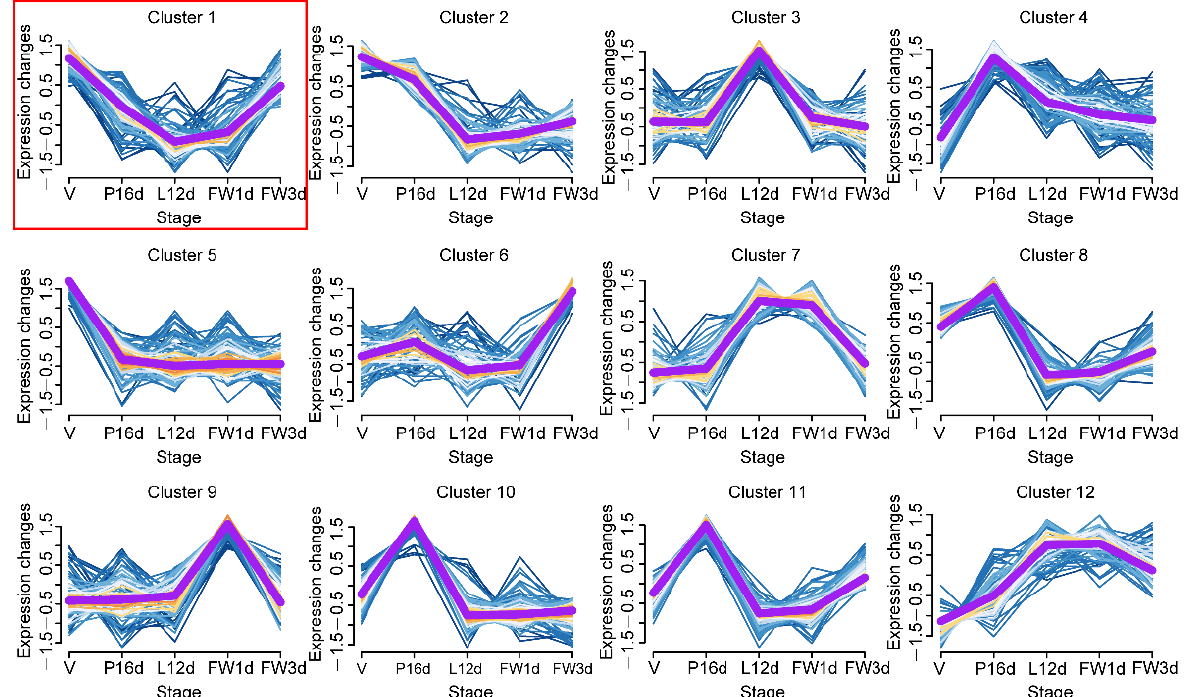
Figure 3. Expression dynamics of 12 miRNA clusters during murine mammary gland development. The purple line represents the miRNAs’ expression trend in each cluster.